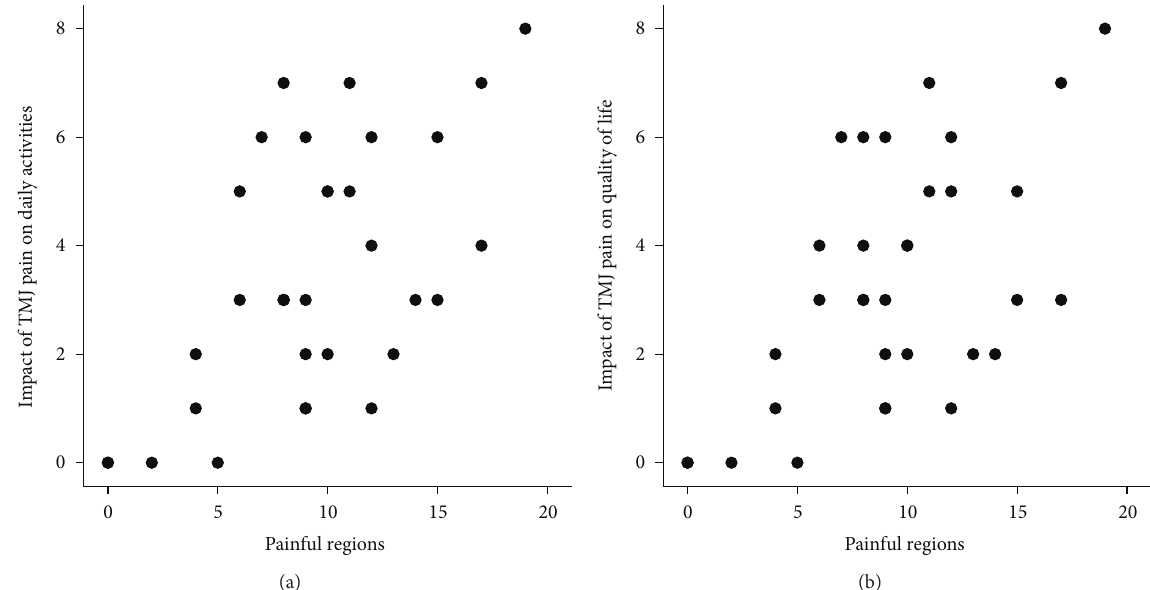
Figure 2: Scatter plots showing the relation between the number of painful regions and the impact of temporomandibular joint (TMJ) pain on daily activities ((a): 𝑟 𝑠 = 0.53 , 𝑛 = 33 , 𝑃 = 0.002 ) and quality of life ((b): 𝑟 𝑠 = 0.49 , 𝑛 = 33 , 𝑃 = 0.004 ).